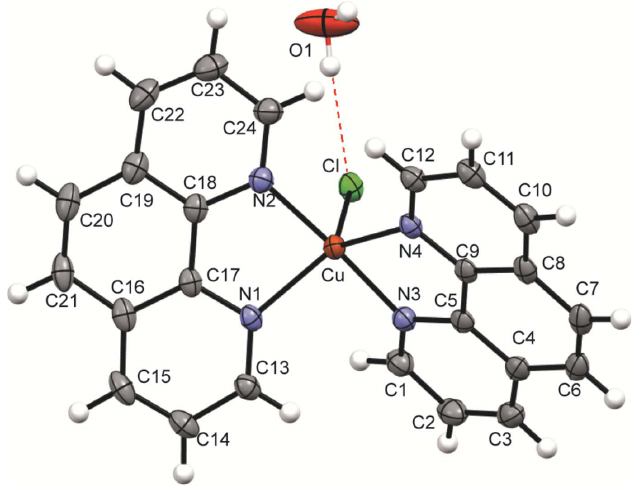
Figure 3 The cation and ordered water molecule in the structure of 4 . Atomic displacement ellipsoids are drawn at the 50% probability